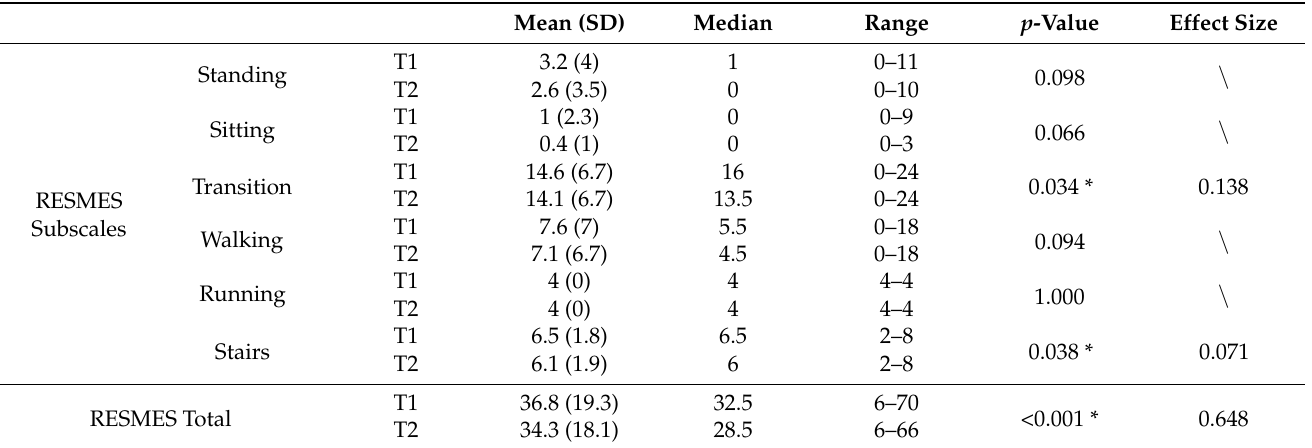
Table 3. Descriptive statistics and corresponding p -value and effect size of participants’ RESMES total and subscales